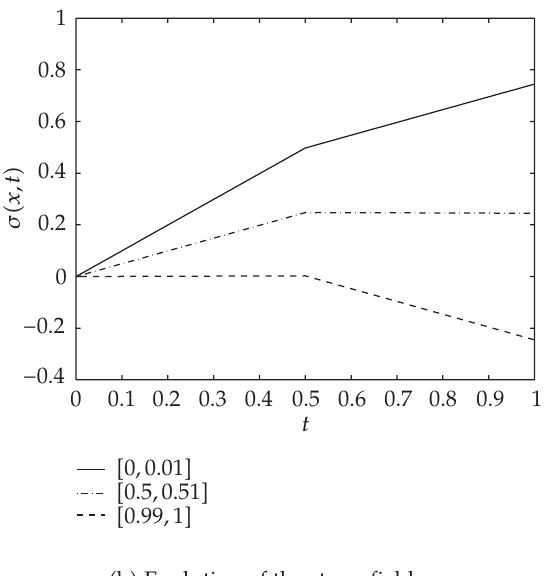
Figure 4.3 . Problem 4.1: evolution in time of displacement and stress fields for several points and